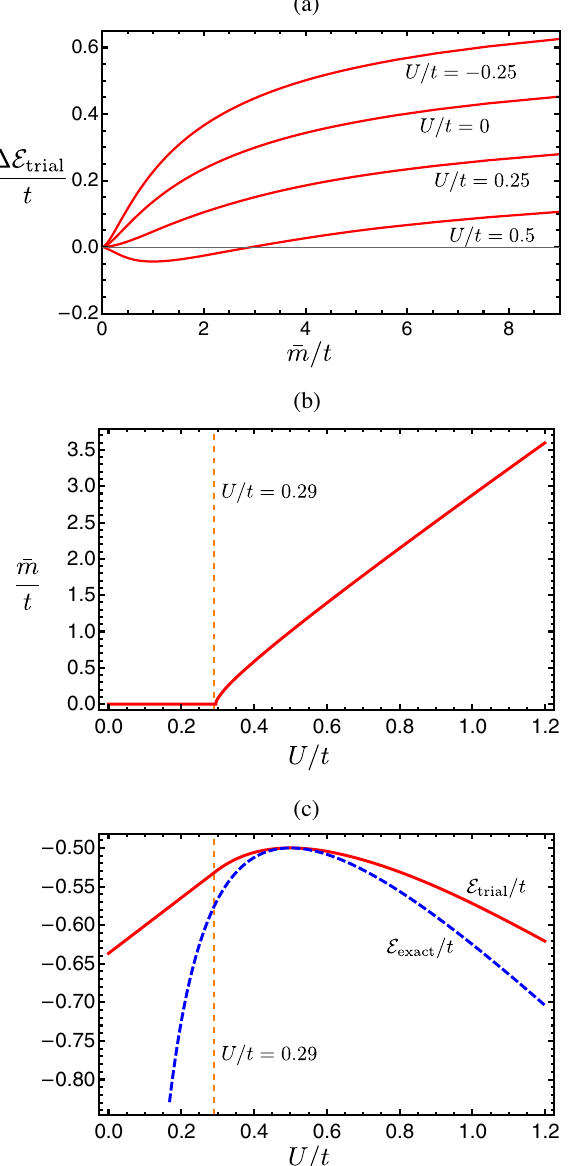
FIG. 14. Variational results for the lattice model given by Eqs. (A16) through (A18) with m ¼ 1 , n ¼ 3 , p ¼ 4 , and g ¼ U . (a) Variational energy difference Δ E [Eq. (A28)] trial versus mean-field dimerization order parameter ¯ m for varying interaction strengths U . At U ≳ 0 . 29 t , the variational energy is minimized by nonzero ¯ m , indicating spontaneous dimerization (as captured by DMRG, but at slightly larger interaction strengths U ≳ 0 . 428 t [87]). (b) Optimal variational ¯ m as a function of interaction strength. (c) Variational ground-state energy E (solid red line) and exact ground-state energy E trial exact (dashed blue line) [87] versus U=t . The two converge at U ¼ t= 2 , at which point the variational approach becomes